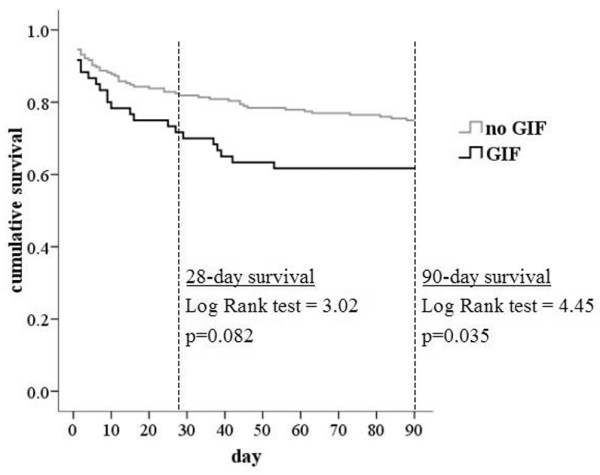
Survival: absence versus presence of gastrointestinal failure. Shown is the cumulative survival of patients without gastrointestinal failure (maximum Gastrointestinal Failure [GIF] score during intensive care unit (ICU) stay ≤ 2) versus patients with gastrointestinal failure (maximum GIF score during ICU stay of 3 or 4).